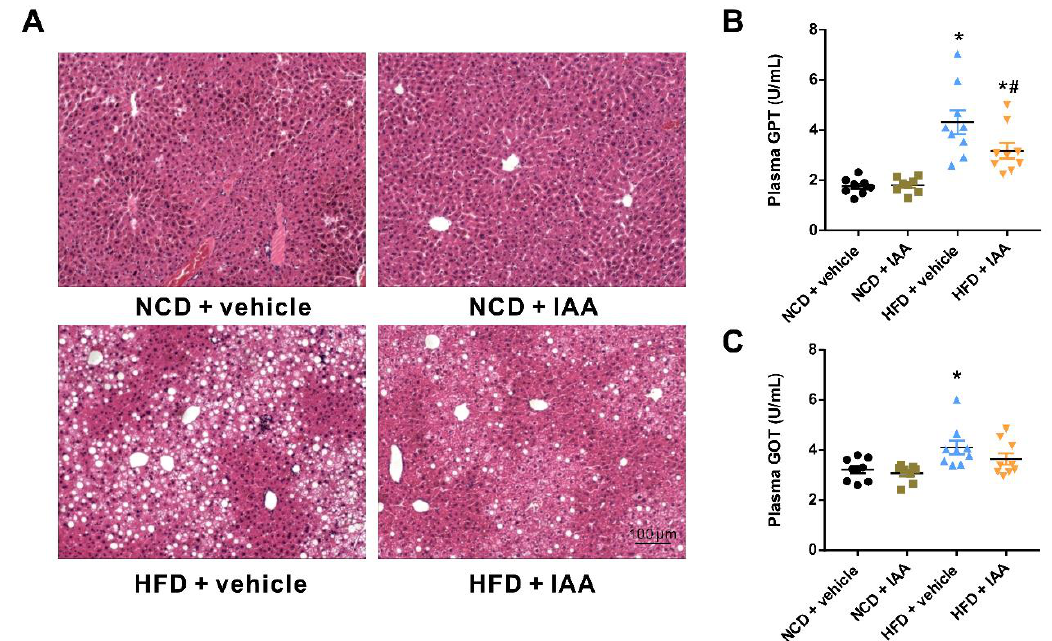
Figure 3. Protective effects of indole-3-acetic acid (IAA) on high-fat diet (HFD)-induced liver injury. ( A ) Representative images of hematoxylin & eosin staining results for liver tissue sections. Scale bar represents 100 µm. ( B ) Plasma glutamic-pyruvic transaminase (GPT) and ( C ) glutamic oxalacetic transaminase (GOT) levels. Data are presented as the mean ± standard error of the mean. n = 8-9. * p < 0.05 vs. NCD + vehicle; # p < 0.05 vs. HFD + vehicle.